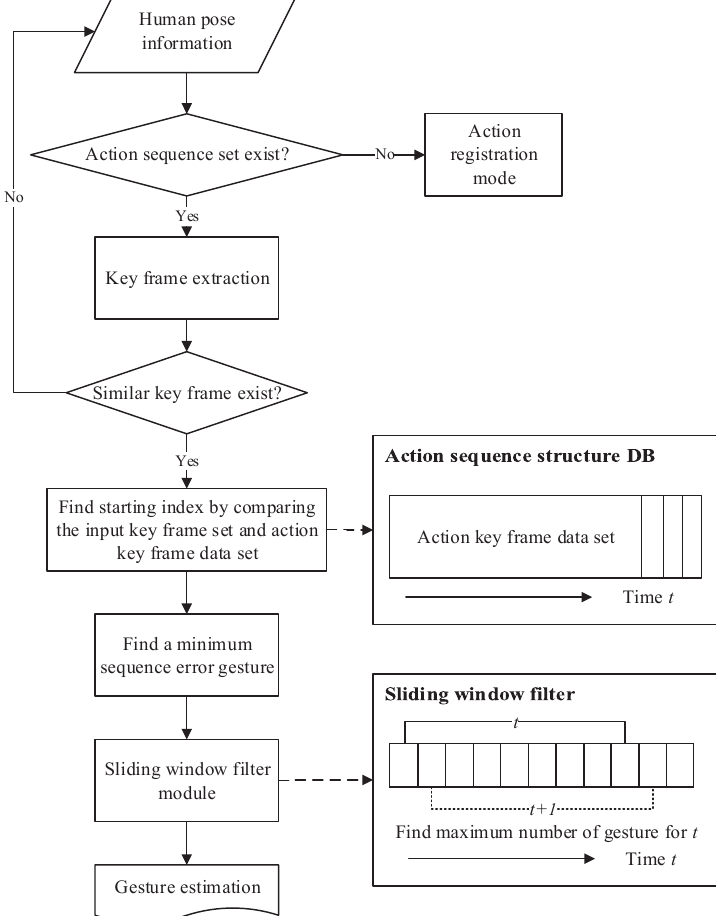
Figure 5. Flow diagram of the proposed gesture recognition